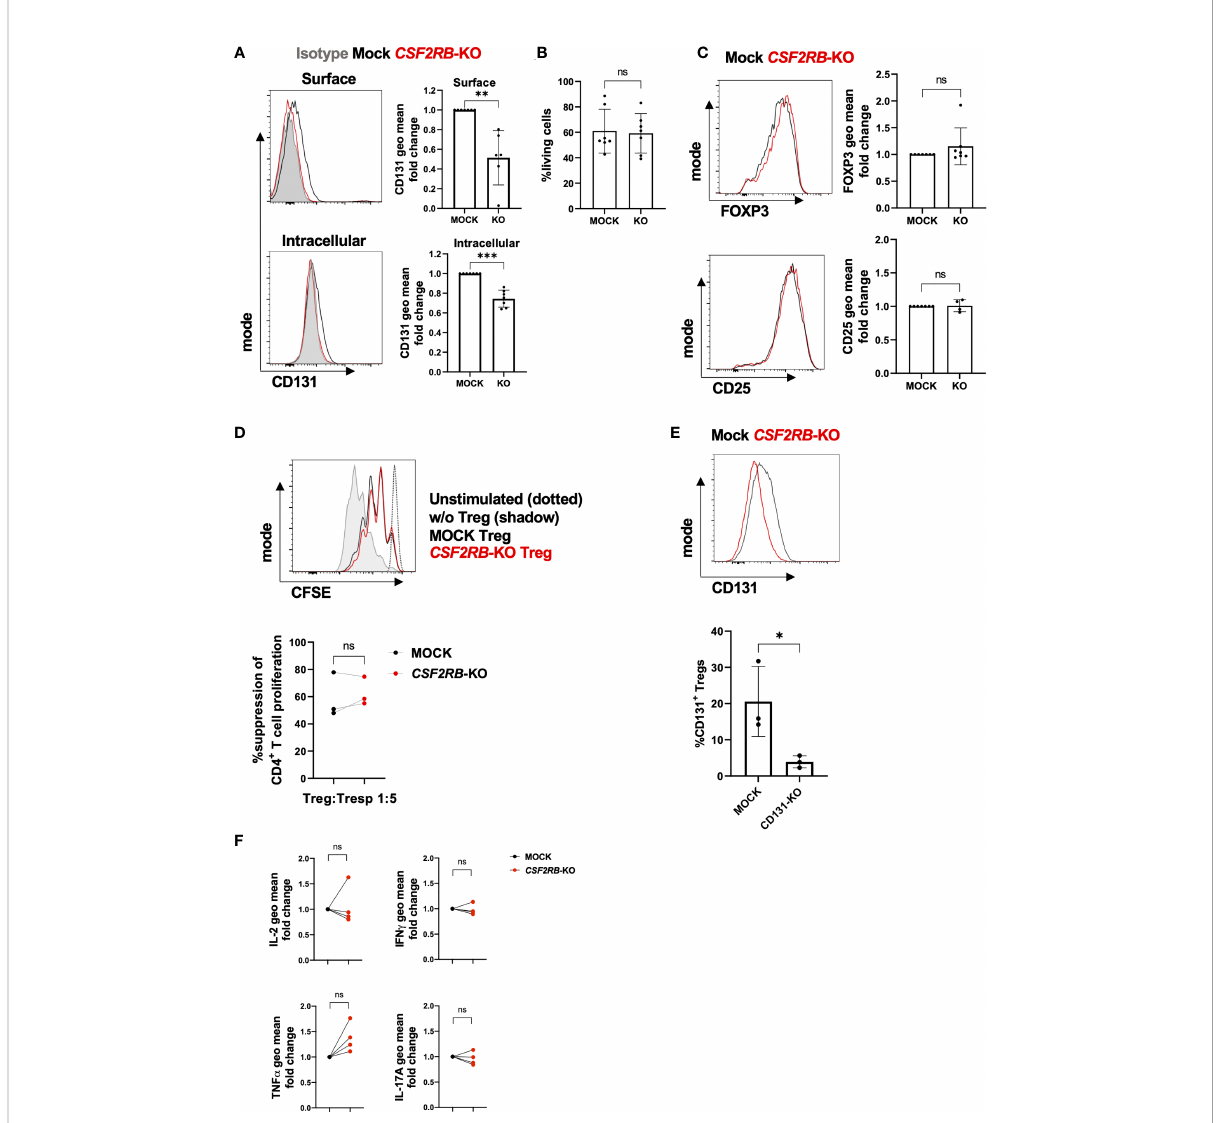
FIGURE 6 Characterization of CSF2RB -KO Tregs (A – E) CD4 + CD25 + CD127 - Tregs were fl ow-sorted from human PBMCs and cultured in vitro for 7 days with 10µg/ml anti-CD3 mAb, 1µg/ml anti-CD28 mAb and 300 U/ml IL-2 prior CSF2RB gene knock-out (KO) by Cas9/sgRNA ribonucleoprotein (RNP) transfection or controls (Mock). (A) CD131 surface and intracellular expression, (B) cell viability and (C) FOXP3 and CD25 expression were studied 3-4 days post-electroporation in 4-7 independent donors. Histograms show data from one representative donor. Isotype (if applicable) is shown as a grey shadow, mock as a black line and CSF2RB -KO as a red line. (D) In vitro suppressive capacity of MOCK or CSF2RB -KO Tregs was assessed by measuring their ability to inhibit proliferation of CFSE-labelled CD4 + CD25 - Tconv (Tresp) when stimulated with monocyte- derived dendritic cells (moDC) and anti-CD3 mAb. Top panel: CFSE expression for one representative donor. Dotted black line: proliferation of unstimulated Tresp; grey shadow: Tresp proliferation in the absence of Tregs; black line: Tresp proliferation when co-cultured with Mock Tregs; red line: Tresp proliferation when co-cultured with CSF2RB -KO Tregs. Bottom panel: percentage of suppression of CD4 + Tresp that diluted CFSE dye is represented for 3 independent donors. (E) CD131 expression was measured by fl ow cytometry in Tregs harvested from suppression assay cultures and gated as live, CD3 + CD4 + CFSE - cells. (F) 4 days after nucleofection, MOCK or CSF2RB -KO Tregs were re-stimulated with anti- CD3/CD28 mAbs and IL-2 for 4 days. Tregs were re-stimulated with PMA and ionomycin in the presence of Brefeldin A prior staining for cytokine expression (n=4 independent donors). Mean ± SD is shown for cumulative data. Normal distribution was calculated by Shapiro-Wilk normality test with a signi fi cance level of 0.05. Signi fi cance was calculated by (A, B, D, E) paired two-tailed t test for normal distributed data or (C) by Wilcoxon matched-pairs test (F) one-way ANOVA with Holm-Sidak ’ s multiple comparisons test. ns for P > 0.05, * for P ≤ 0.05, ** for P ≤ 0.01, *** for P ≤